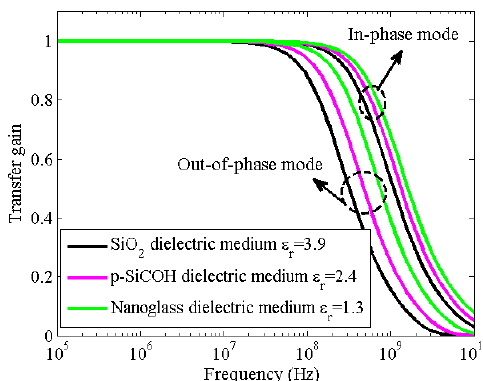
Figure 4. The impacts of different dielectric materials on frequency response of victim line under in-phase and out-of-phase modes. Here, the interconnect length L gnr = 1000 µm.